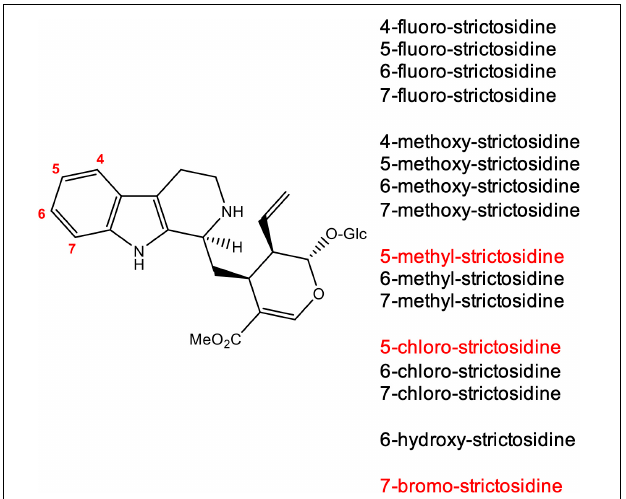
FIGURE 2 | Strictosidine analogs produced in vitro using tryptamine analogs and secologanin. The reaction was catalyzed by Cr STR. Strictosidine analogs shown in red were not turned over by Cr STR or were not produced in high enough levels for isolation.